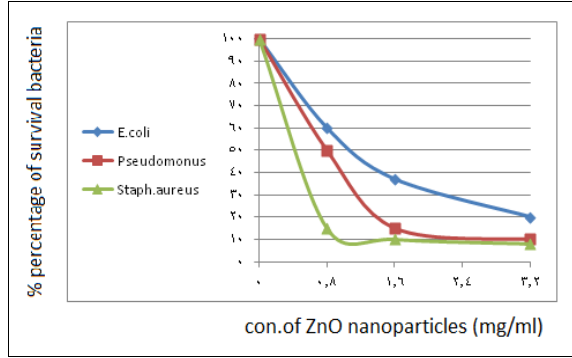
Figure, 5: Percentage of survival rate of bacteria in different concentration of ZnO